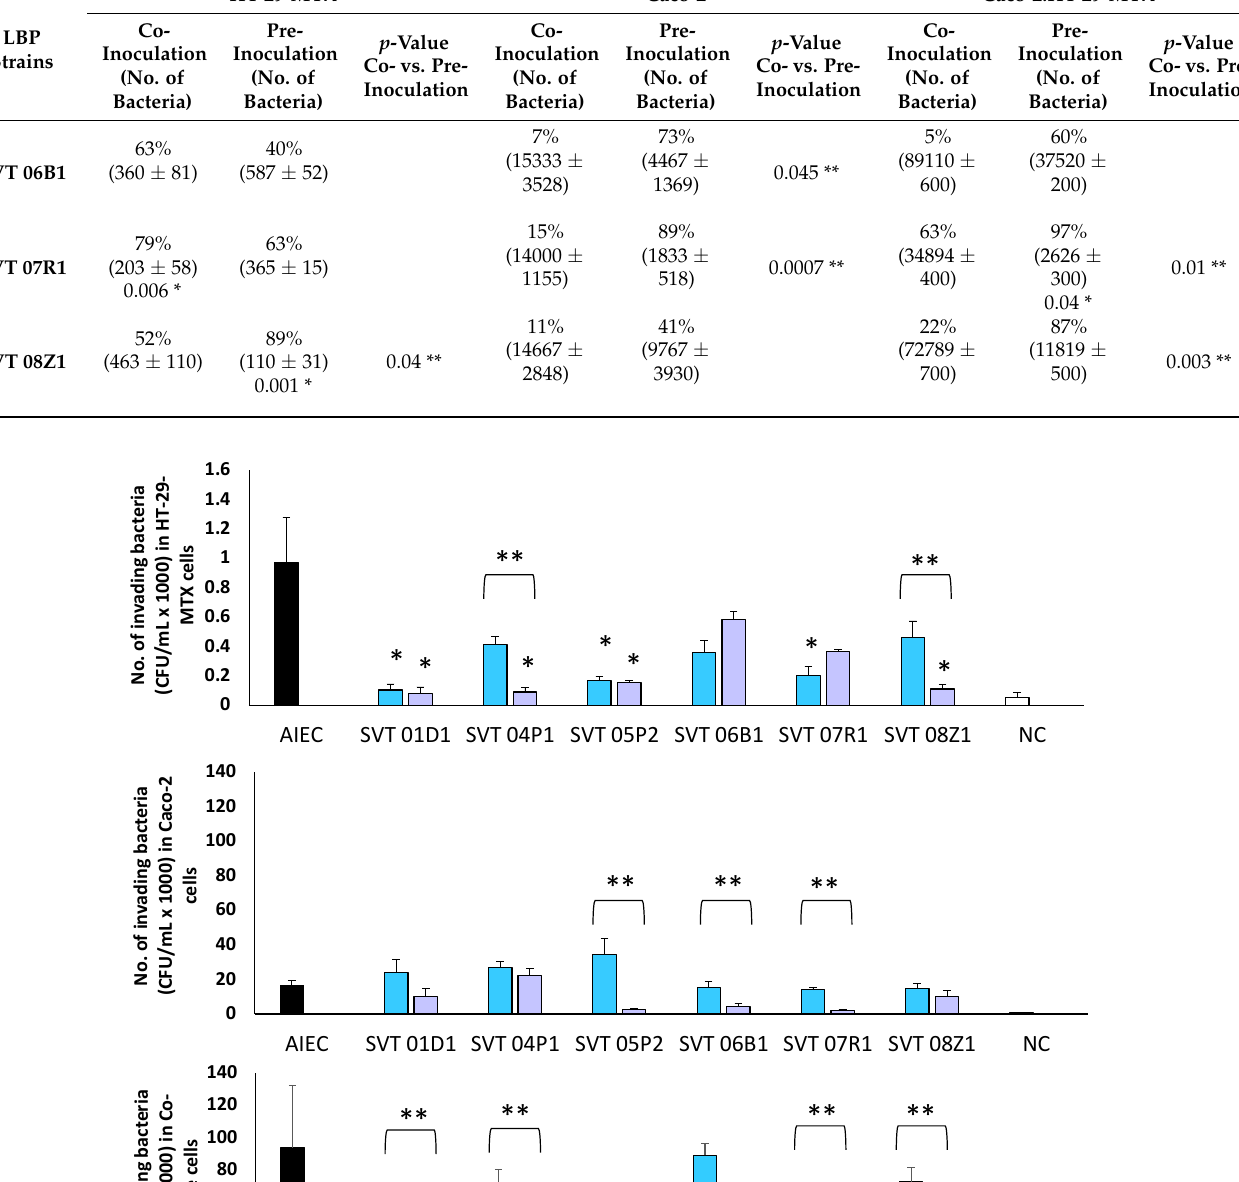
compared to co-inoculation (Table 1). AIEC on its own showed a significantly better abil- ity to adhere to HT29-MTX cells (8.9 ± 0.9) ( p < 0.0001) and Caco-2 cells (6.9± 0.5) ( p =